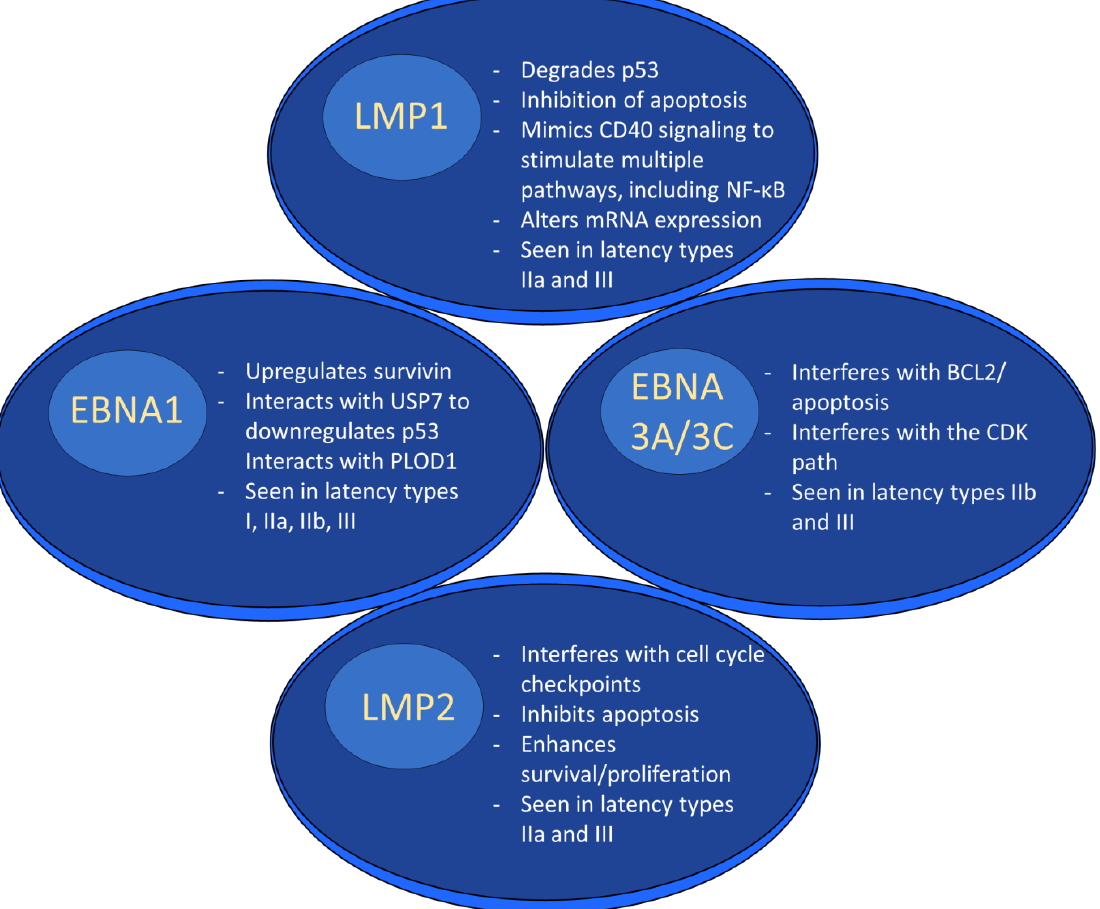
Figure 2. EBV latent proteins and oncogenesis. EBV latent proteins play numerous roles in facilitating oncogenesis. For example, LMP1 degrades p53, alters mRNA expression and stimulates multiple pathways through mimicking CD40 signaling. EBNA1 upregulates survivin, downregulates p53, and interacts with PLOD1. EBNA3A/3C interferes w/BCL2/apoptosis and interferes with the CDK pathway. LMP2 interferes with the cell cycle, inhibits apoptosis, and enhances survival/prolif- eration.